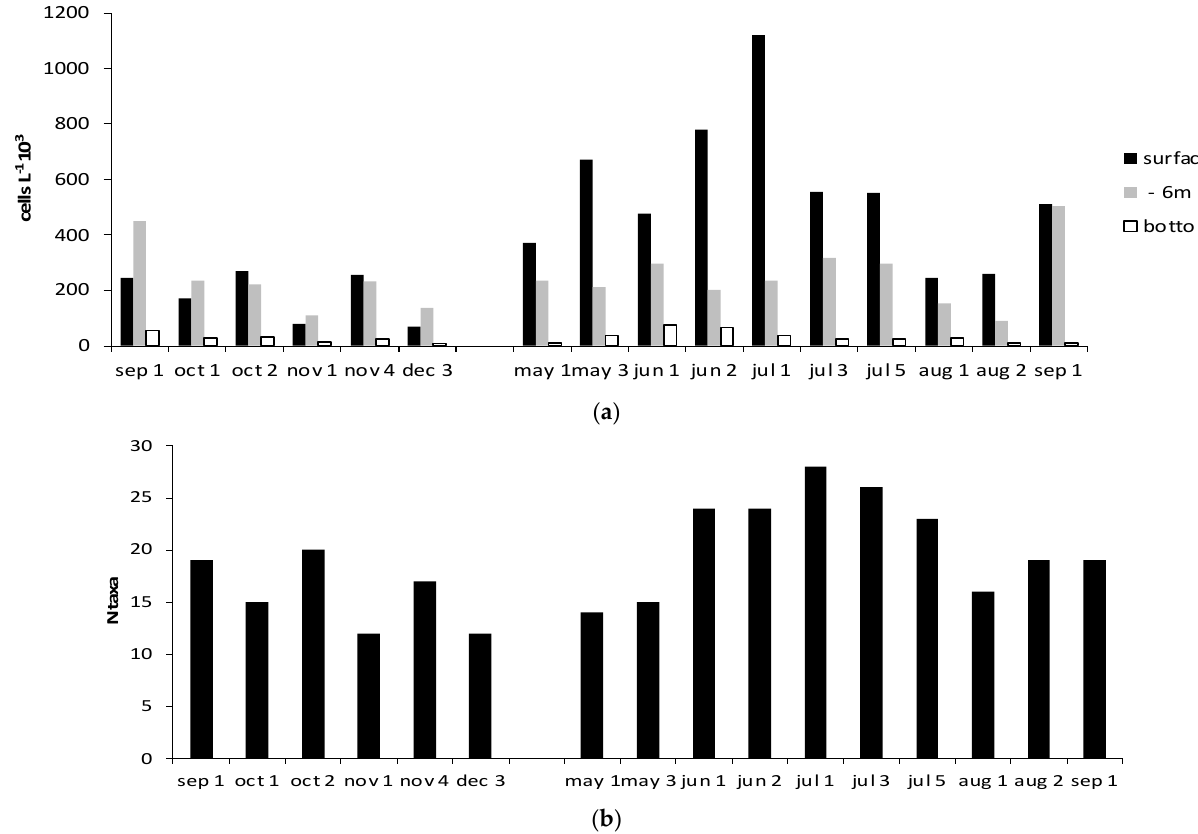
Figure 4. Temporal variation (abundance and taxa richness) of Dinophyta at three different depths (sub-surface, − 6 m, and bottom at − 11 m) in the Mar Piccolo, Taranto. ( a ) Abundance (cells 10 3 L − 1 ) for the three depths of sampling; ( b ) number of taxa in each sampling date (all the depths together).